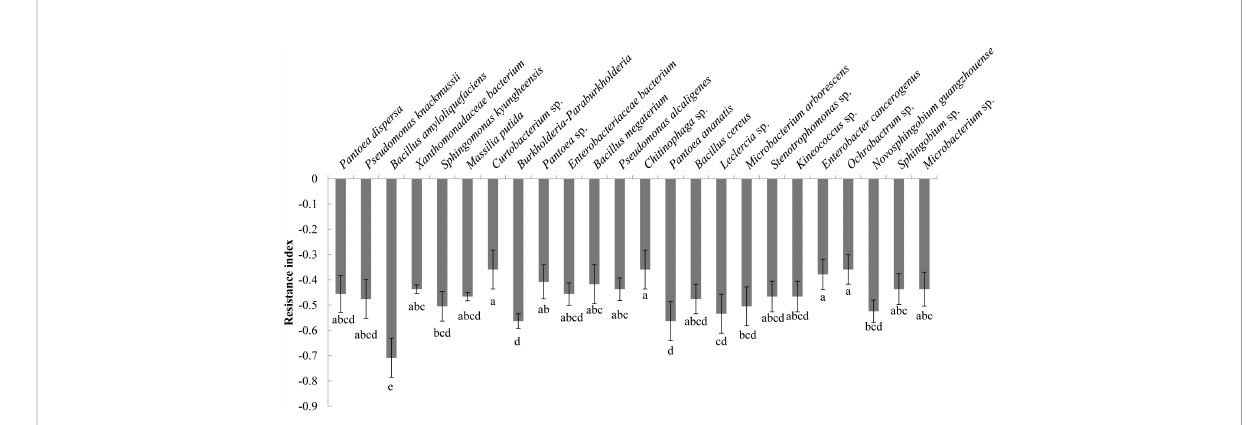
FIGURE 4 The allelopathy index (resistance index) of the bacterial isolates. Values marked with different letters are signi fi cantly different at p<0.05.